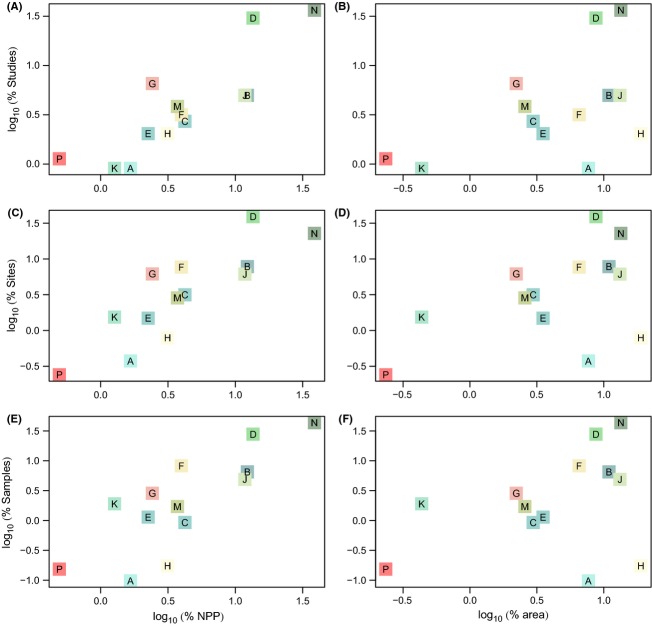
Coverage of biomes. The percentage of Studies (A and B), Sites (C and D) and samples (E and F) against percentages of terrestrial NPP (A, C and E) and terrestrial area (B, D and F). Biome colors and letters are as in Fig. 1.